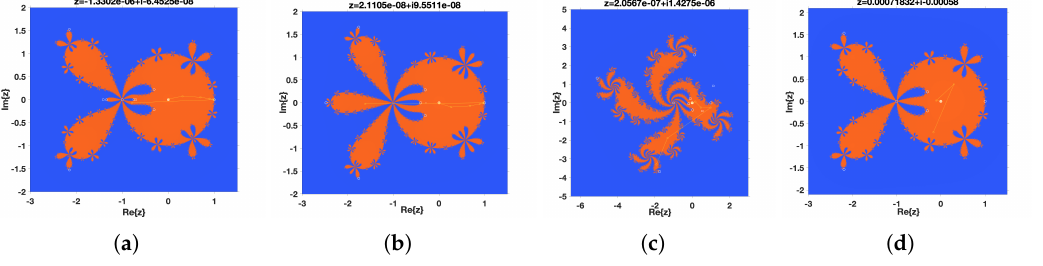
Figure 5. Dynamical planes whose behavior is stable. ( a ) β “ 1. ( b ) β “ 10. ( c ) β “ 100 ´ 200 i . ( d ) β “ 0.